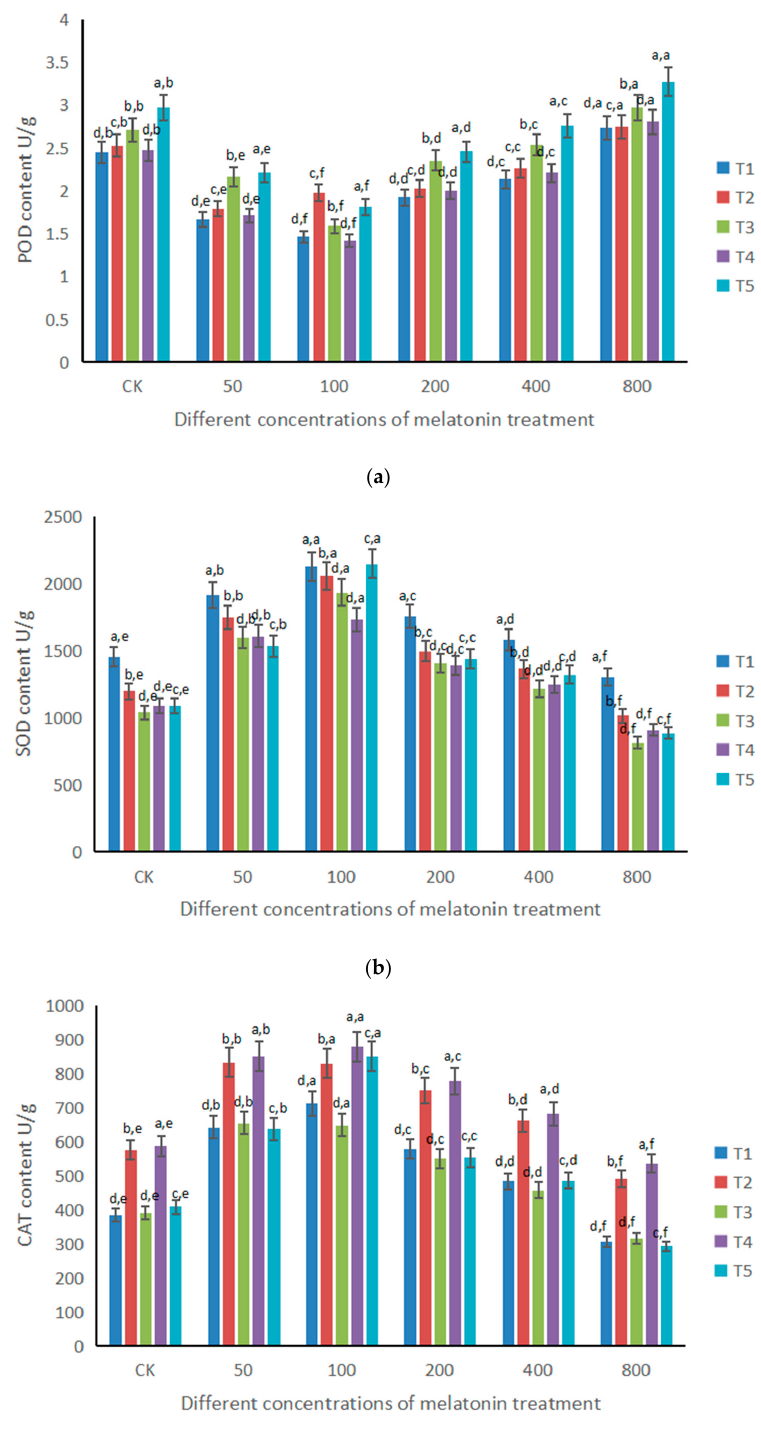
Figure 2. Relative CAT, SOD and POD content of Populus cathayana × canadansis ‘Xin lin 1’ leaves under control and different MT treatment base on salt and alkaline stress in different time periods of the experiment. T1 means 10 days, T2 means 14 days, T3 means 18 days, T4 means 22 days, T5 means 26 days. Each value is the average ± standard error (±SE). For two ‐ way ANOVA, the letters on the left represent the detection phase ( p < 0.05) and the letters on the right represent the experimental concentrations ( p < 0.05). ( a ) Changes of POD content, ( b ) changes of SOD content, ( c ) changes of CAT content.